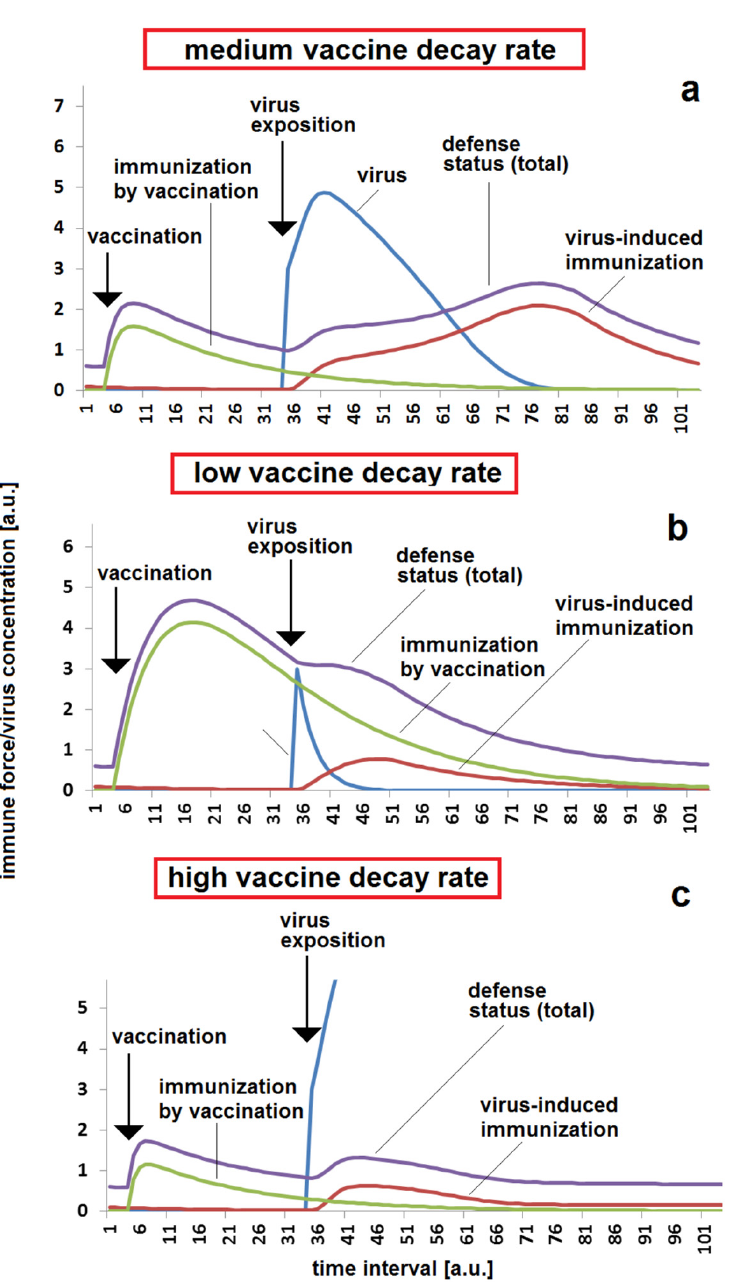
Figure 7. Effect of vaccine decay rate in the response to a massive viral impact after a moderate time between vaccination and virus exposition: ( a ) moderate protection by vaccination, meaning a significant reaction, but there is protection against a heavy illness in the case of a moderate vaccine decay rate, D vacc = 0.4; ( b ) safe protection and low reaction to virus exposition in the case of a low vaccine decay rate, D vacc = 0.1; ( c ) low protection by vaccination due to fast vaccine decay rate resulting in breakthrough in the case of a viral exposition, D vacc = 0.6. The same set of other parameters were used for all simulations ( a – c ): k vir = 0.3; k r = 0.12; k st = 0.08; D AB = 0.05; c BGim = 0.5; v oo = 30; st oo = 10.